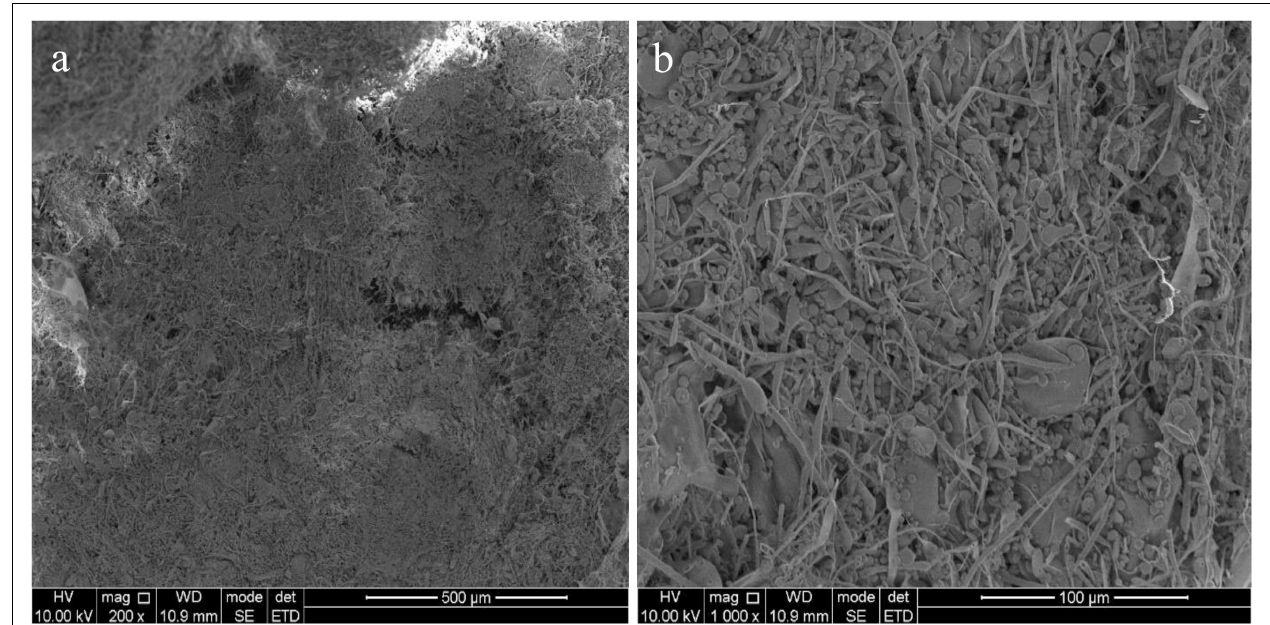
FIGURE 5 | SEM images of EPS-F2 under 200 × (a) and 1000 × (b) magnification.